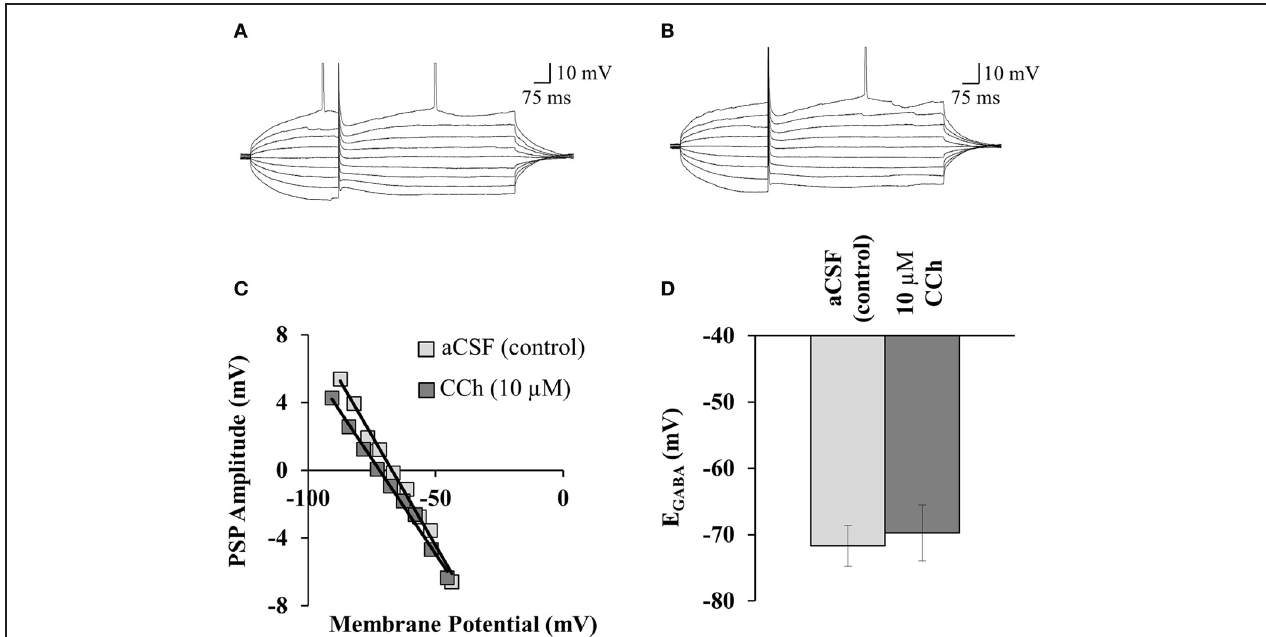
FIGURE 1 | mAChR activation does not alter E GABA . Sample traces show the current clamp protocol used to record E GABA after (A) 10min of 10 µ M CNQX, and (B) 10min after the addition of 10 µ M CCh in the same neuron. The mean resting membrane potential is − 66 . 29 ± 0 . 31mV in 10 µ M CNQX, and − 67 . 67 ± 0 . 28mV with the addition of 10 µ M CCh. (C) Sample PSP amplitude vs. membrane